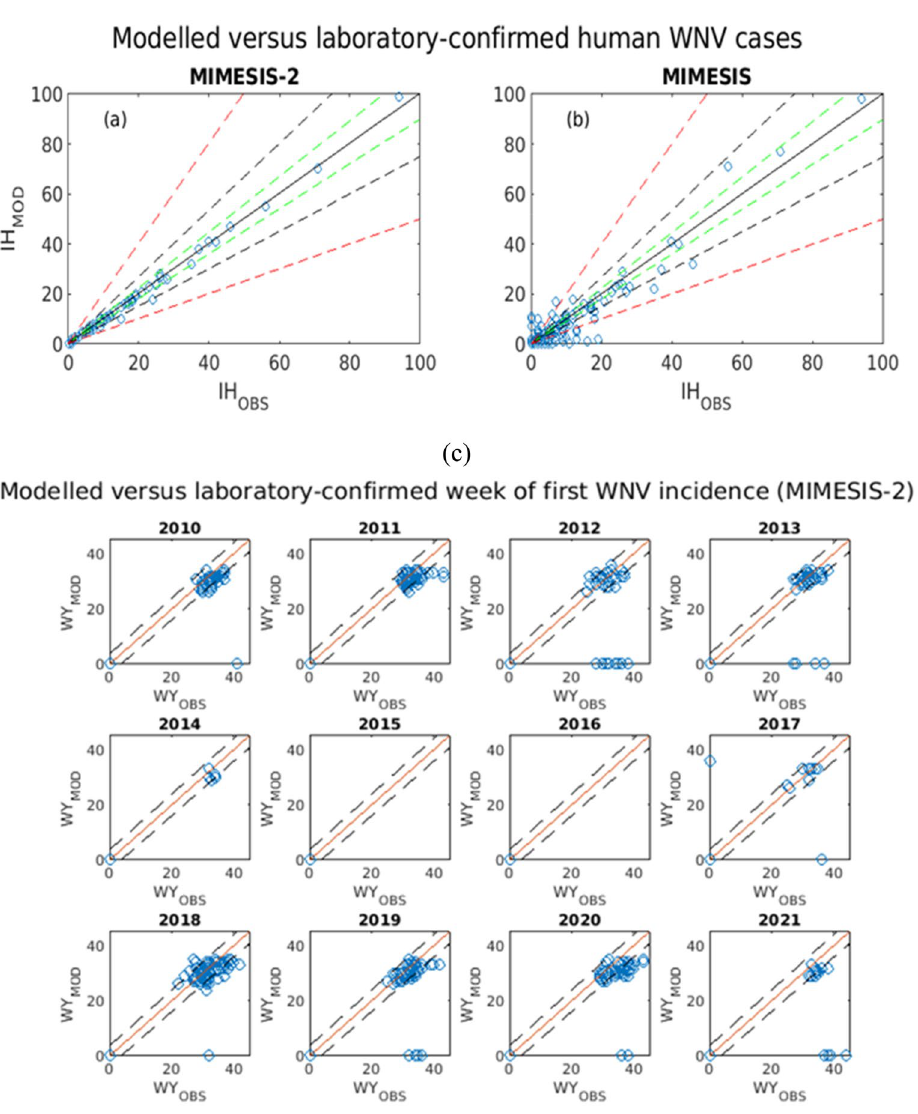
Figure 2. ( a ) For MIMESIS-2, modelled ( IH MOD ) vs. observed ( IH OBS ) human WNV cases in each municipality in the period 2010–2021. The inner black line represents the main diagonal where ideally the points would lie in case of perfect fit, while the dashed green, black and red lines represent, respectively, the ± 10%, ± 25% and ± 50% error margin. ( b ) Same quantities for MIMESIS. (c). Breakdown of the week of first WNV incidence by year. Plotted are the modelled quantities (WY MOD ) for each of the 325 municipalities on the y-axis and the observed quantities (WY OBS ) on the x-axis. The continuous line represents the main diagonal where ideally the points would lie in case of perfect fit, while the dashed lines represent the ± 4-week error